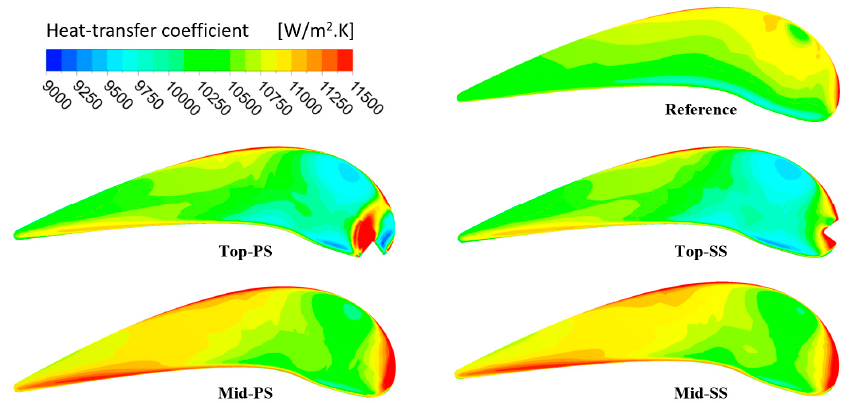
Figure 15. Heat-transfer coefficient distribution on the R 1 blade tip under different damaged-blade conditions.